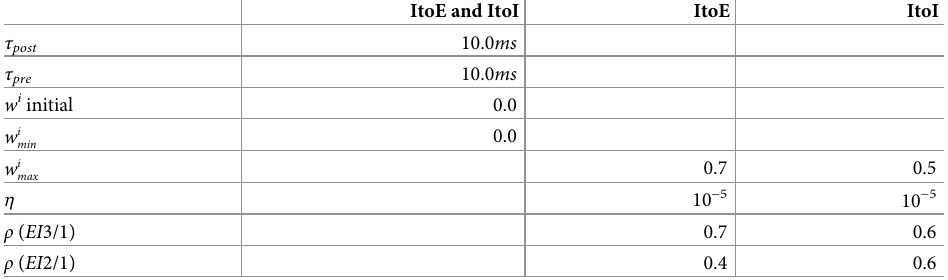
Table 2. Parameters for inhibitory